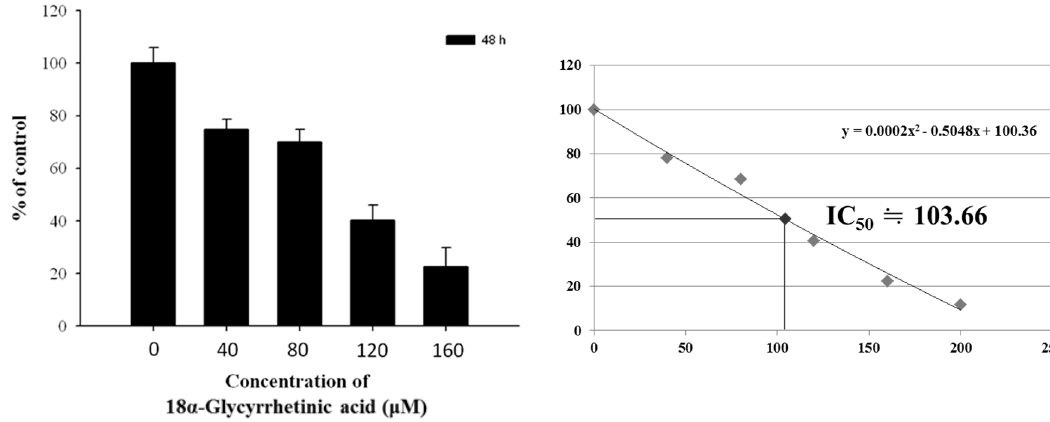
Figure 1. 18 α -GA induced cytotoxic effects on human leukemia HL-60 cells. HL-60 cells (1 × 10 4 cells/well)